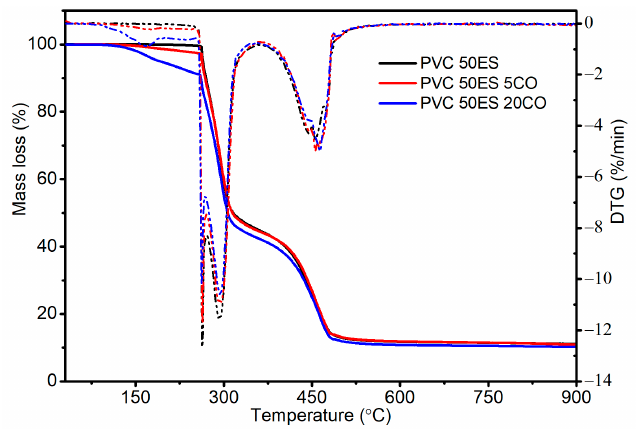
Figure 6. TGA (solid curve) and DTG (dotted line) thermograms of selected PVC materials. Table 3. The TGA analysis results.